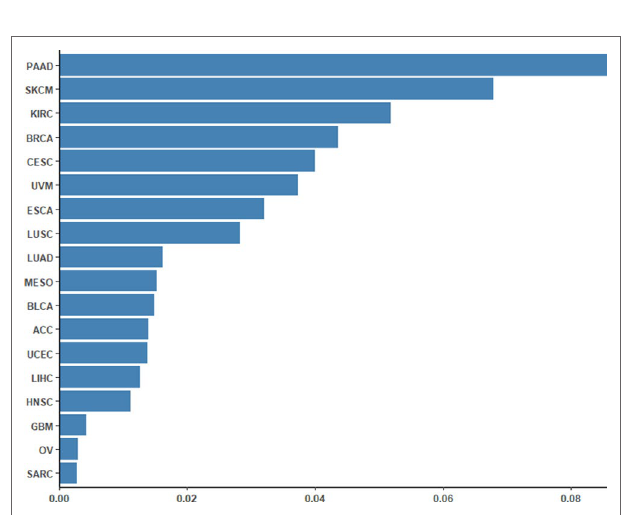
FIGURE 2 | Differences between the predicted ORRs and true ORRs of 18 cancer types. Except for PAAD, SKCM, and KIRC, most of the ORRs of the cancer types could be predicted fairly robustly.